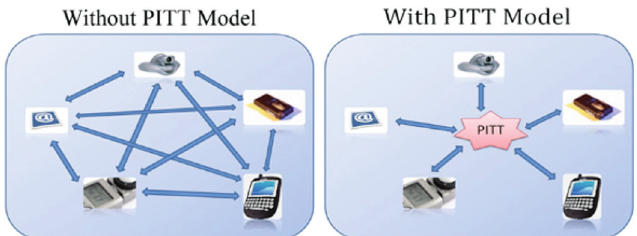
Figure 2. Integration of System: With and without PITT